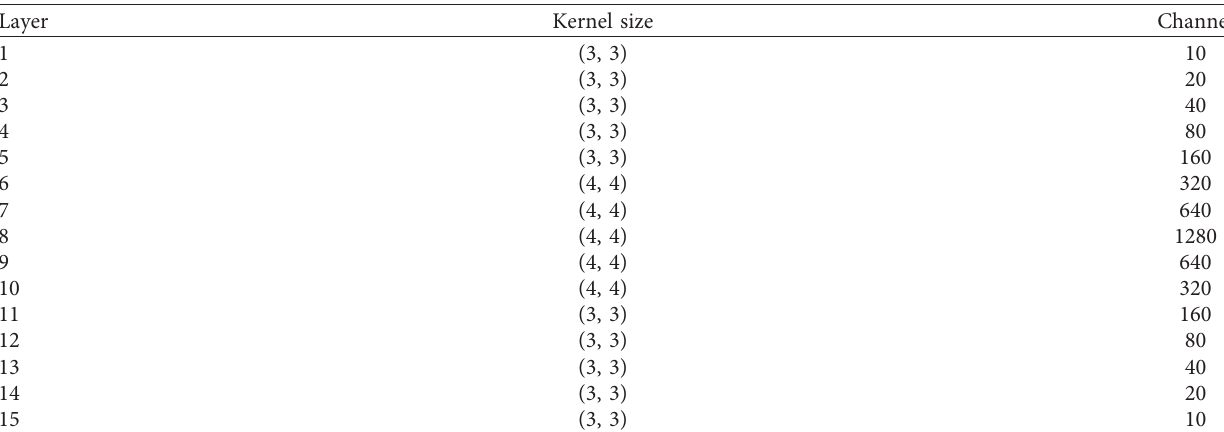
Table 1: The configuration of the